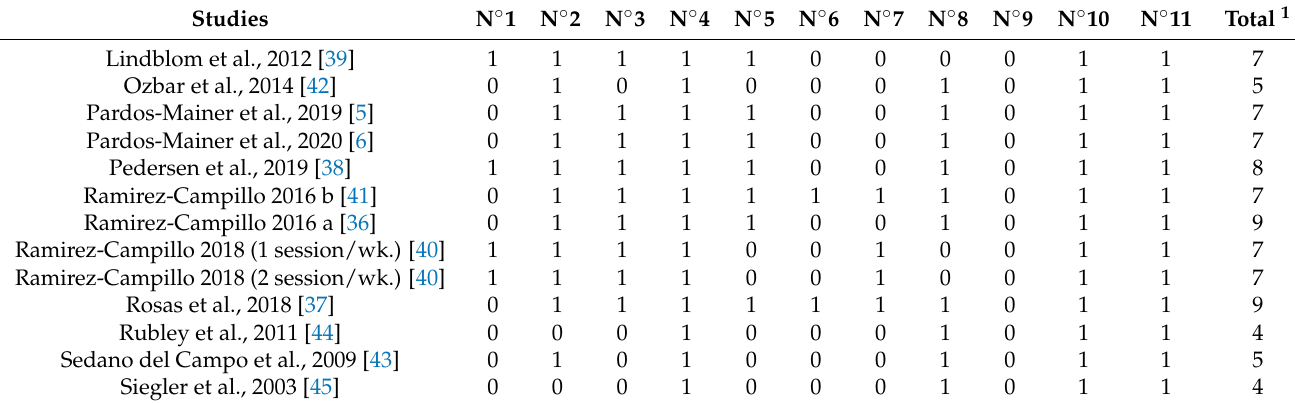
Table 1. The Physiotherapy Evidence Database (PEDro) scale